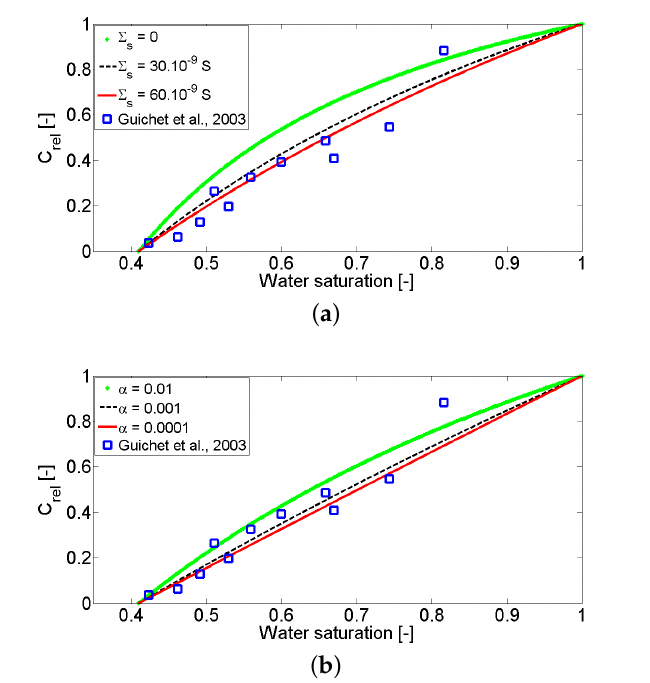
Figure 5. The variation of the relative SPCC with water saturation for a sand column saturated with brine/argon (see symbols) taken from the work in [48]. The lines are predicted from Equation (29) for three different values of Σ s = 0, 30 × 10 − 9 S and 60 × 10 − 9 S ( a ) and three different values of α = 0.01, 0.001 and 0.0001 ( b ). Input parameters for modeling are S wirr = 0.41, d = 300 µ m, φ = 0.4, σ w = 0.01 S/m that are reported by [48]. In panel (a), α = 0.01 is used and in Figure 5b, Σ s = 30 × 10 − 9 S is